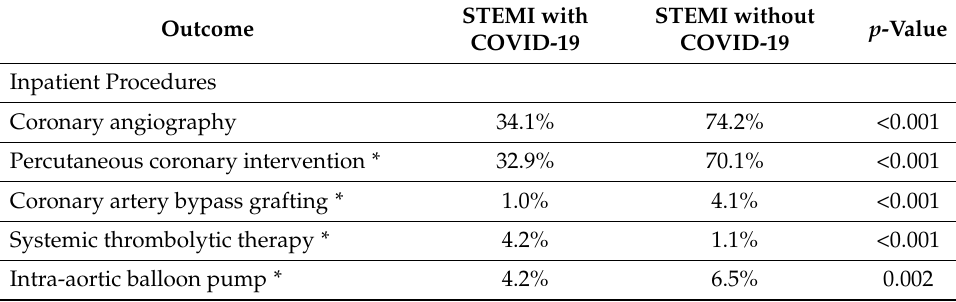
Table 4. Inpatient Procedures and Cardiovascular Complications Among Hospitalized STEMI Patients, Stratified by COVID-19